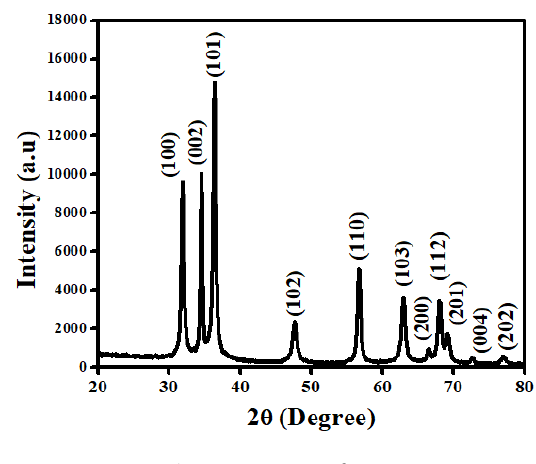
Fig. 4. XRD pattern of